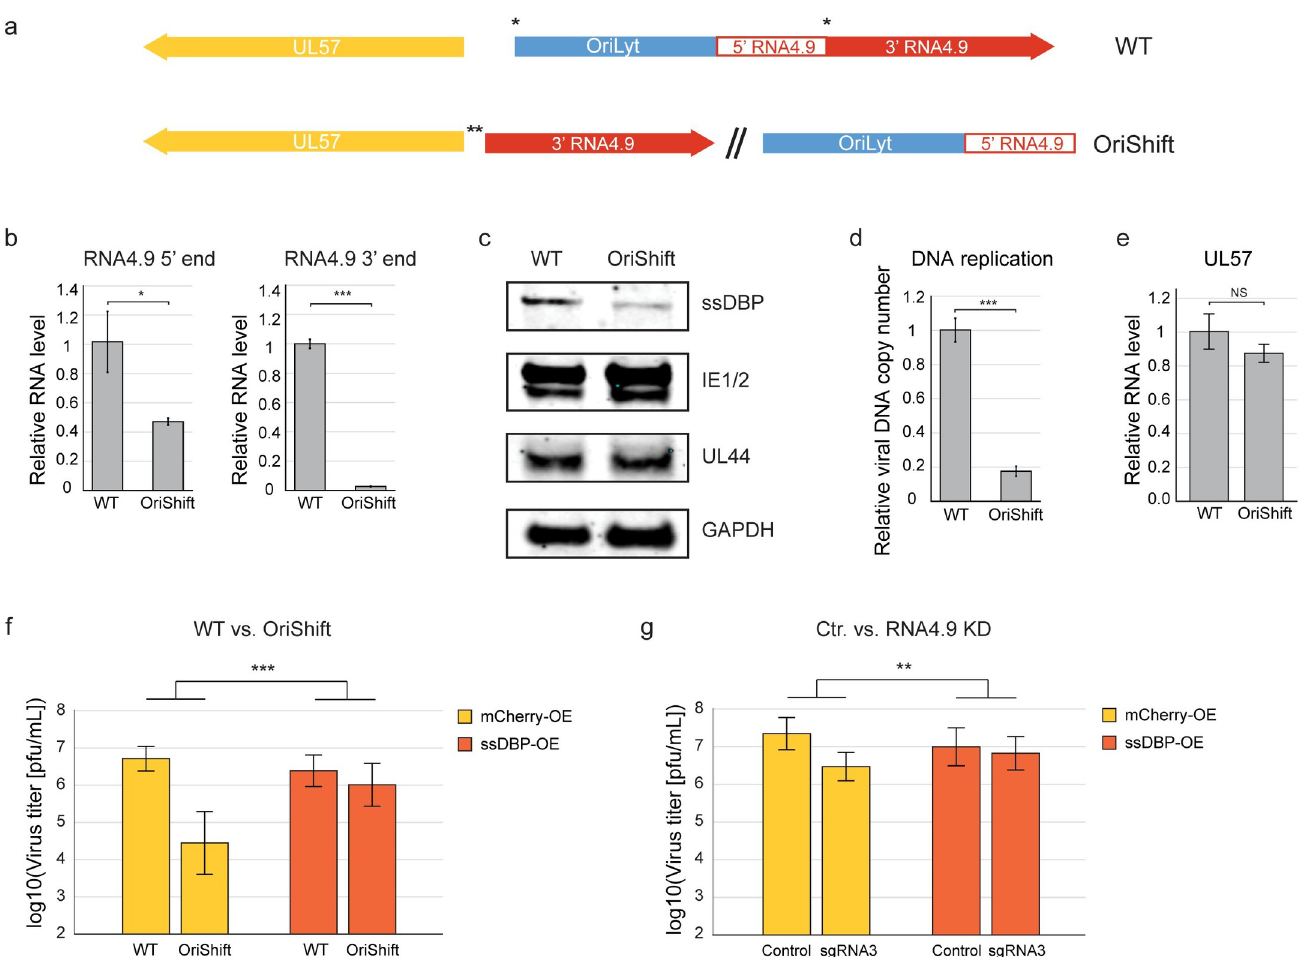
Fig 7. ssDBP overexpression rescues the defect caused by interference with RNA4.9 expression. a) Schematic representation of the OriShift mutant [27]. Asterisks mark the genomic location of the shifted oriLyt region. b, c and e) Fibroblasts were infected with OriShift mutant or the parental AD169 WT virus (MOI = 1), treated with PFA, and harvested at 48 hpi. b) Relative RNA4.9 5’ and 3’ transcript levels were quantified using RT-qPCR and normalized to the cellular ANXA5 transcript. c) ssDBP, IE1/2 and the UL44 protein were detected by immunoblot analysis. Human GAPDH was used as loading control. d) Fibroblasts were infected with OriShift mutant or the parental AD169 WT virus (MOI = 1) and harvested at 48 hpi, and relative viral DNA levels were quantified by qPCR using UL44 primers and normalized to the cellular gene B2M. e) Relative UL57 transcript levels were quantified using RT-qPCR and normalized to the ANXA5 cellular transcript. f—g) Fibroblasts overexpressing mCherry as control (yellow) or ssDBP (orange) were either infected with the OriShift mutant or the parental WT virus (MOI = 1) (f) or transduced with CAS9 and either a control sgRNA or a sgRNA targeting RNA4.9 (sgRNA3) and infected with HCMV Merlin strain (MOI = 1) (g). Viral titers were measured at 5 dpi by TCID50. b, d and e) Values and error bars represent the average and SD of triplicates. b-g) A representative analysis of at least two independent experiments is shown. b, d and e) two-sided t -test, as well as f-g) two-way ANOVA was applied ( ��� p-value < 0.001, �� p-value < 0.01, � p- value < 0.05, NS, not